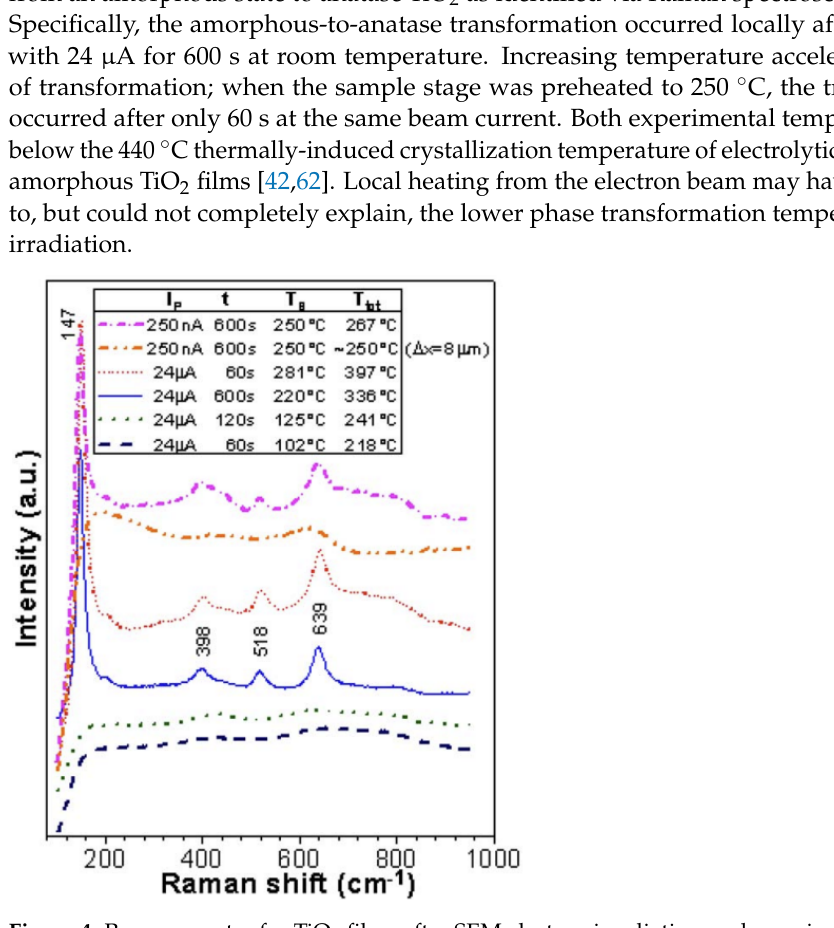
Figure 4. Raman spectra for TiO 2 films after SEM electron irradiation under various beam current, temperature, and time conditions. Reproduced from ref. [42].